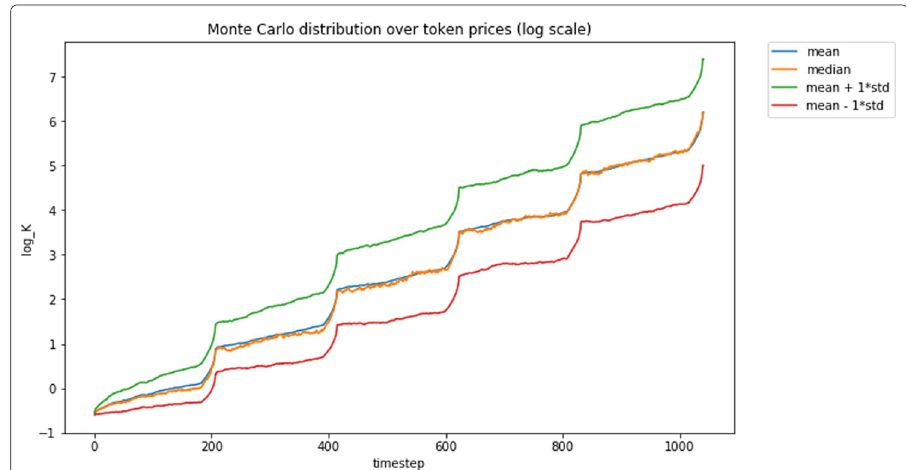
Fig. 2 Token prices over 1,040 weeks; statistics from 100 Monte Carlo Runs under step decay block reward schedule on log scale